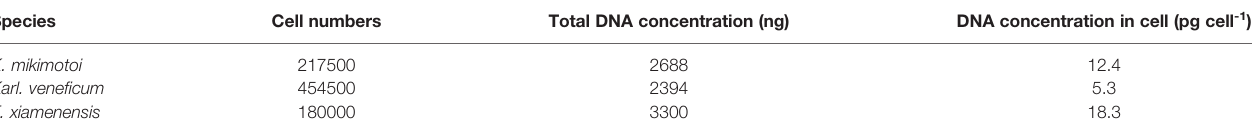
TABLE 6 | Cell numbers and DNA concentration of the target algae. Species Cell numbers Total DNA concentration (ng) DNA concentration in cell (pg cell -1